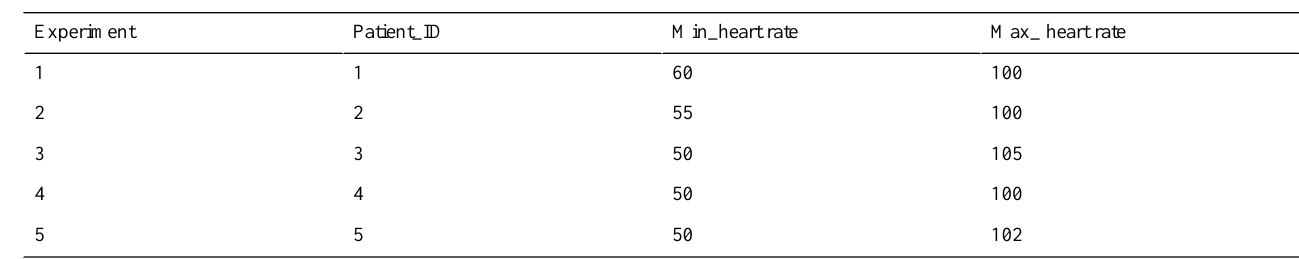
Table 2. Defining the anomaly thresholds of heart rate sensor for each